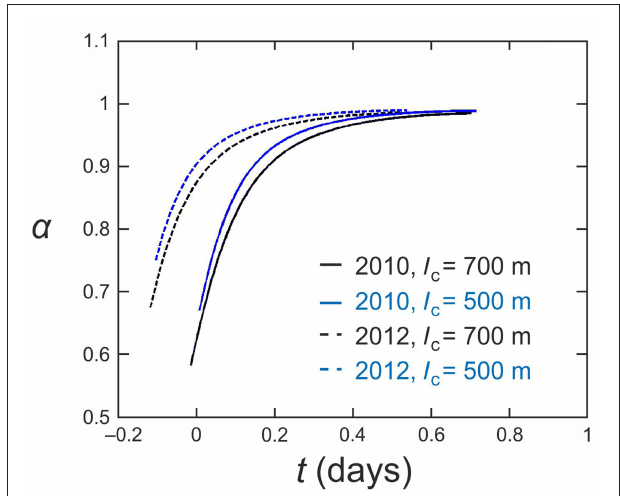
FIGURE 8 | Variation of the thermal partitioning coefficient α in the four model runs for the 2010 and 2012 outbursts in Figure 5 , with l c curves) and l c 500m (blue =